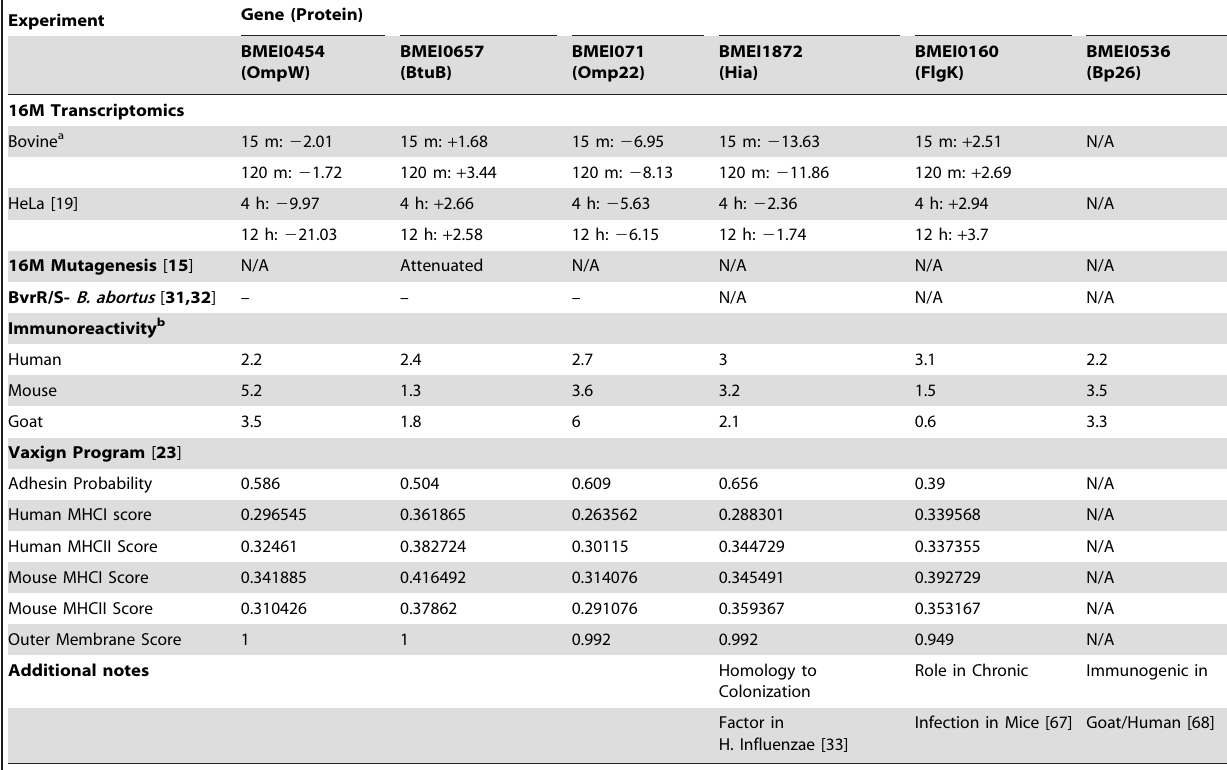
Table 2. Summary of Published and Experimental Findings.